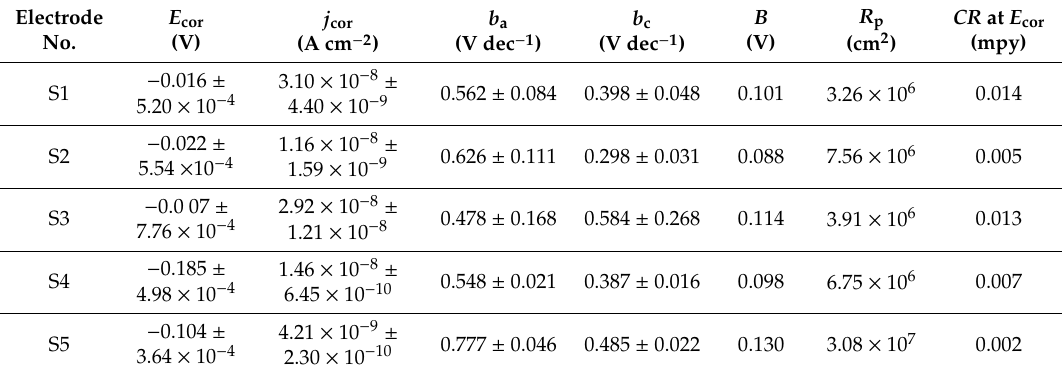
Table 3. The parameters of corrosion resistance for the AISI 1010 electrodes in sulfolane at 25 ◦ C determined based on analysis of the Tafel plots shown in Figure 5 and according to ASTM G102-89(2015)e1: Standard Practice for Calculation of Corrosion Rates and Related Information from Electrochemical